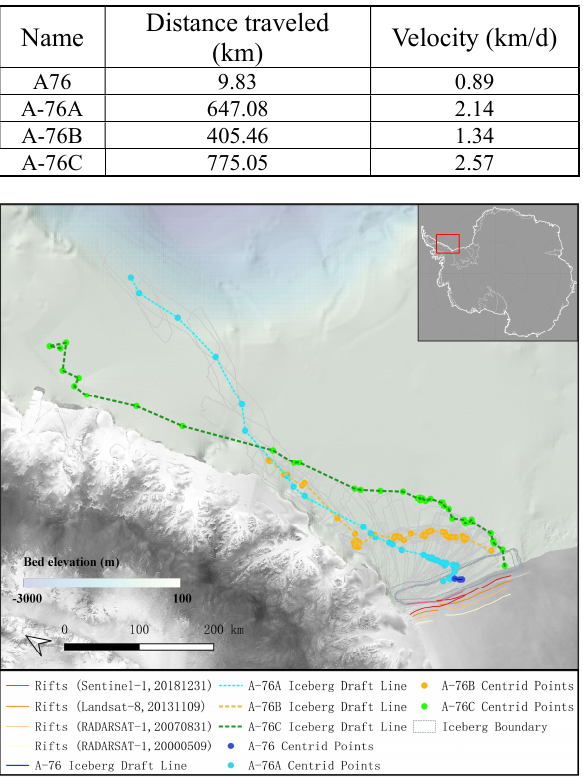
Table 2. Relative displacements and velocities of the A-76, A- 76A, A-76B, and A-76C icebergs derived from the image dataset.